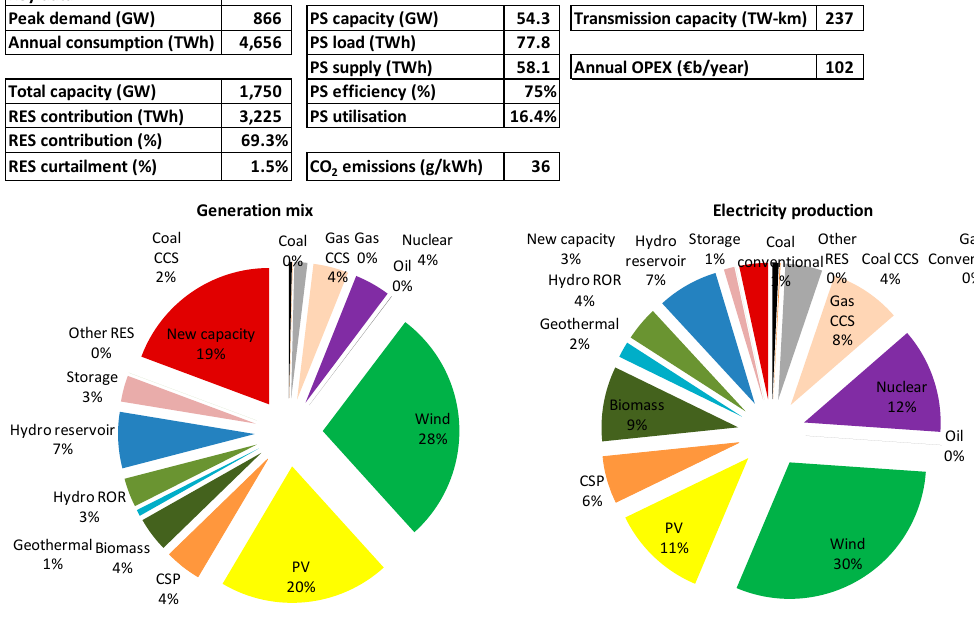
Figure A7. High RES scenario for 2040.